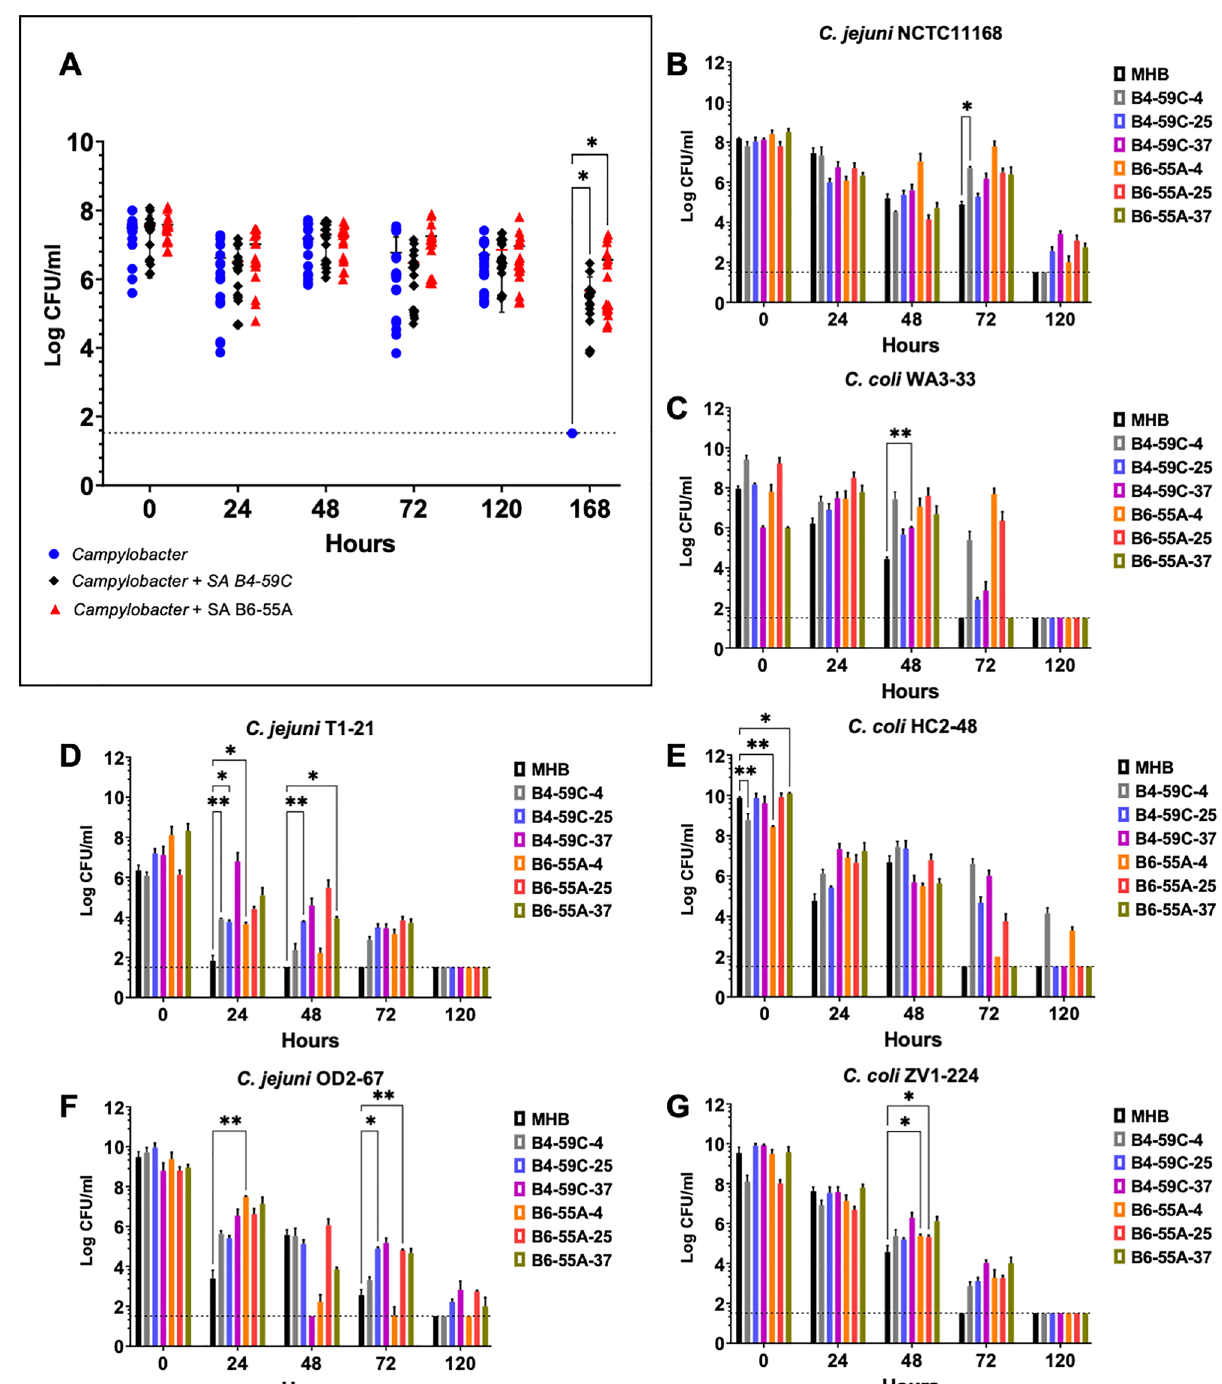
Figure 1. Survival of Campylobacter strains at low temperature (4 °C) in mono or mixed cultures containing S. aureus strains or cell-free extracts. ( A ) Survival of Campylobacter strains (all C. jejuni and C. coli strains) monocultures and mixed cultures containing S. aureus B4-59C or B6-55A. All individual viable count readings from Campylobacter monocultures or mixed cultures are represented in figure ( A ). Survival of ( B ) C. jejuni NCTC11168, ( C ) C. coli WA3-33, ( D ) C. jejuni T1-21, ( E ) C. coli HC2-48, ( F ) C. jejuni OD2-67 and ( G ) C. coli ZV1-224 in media containing cell-free extracts of S. aureus at 4 °C. The cell-free extracts were obtained from S. aureus B4-59C grown at 4, 25, and 37 °C (B4-59C-4, B4-59C-25, B4-59C-37) and S. aureus B6-55A grown at 4, 25, and 37 °C (B6-55A-4, B6-55A-25 and B6-55A-37). Campylobacter cells grown in non-amended MHB served as a control. Each bar in figures ( B – G ) represents the mean of colony counts with standard deviation (SD) error bar. Horizontal dotted lines in the figures represent the limit of detection for colony counts (LOD, ~ 33 CFU/ml) in these assays. All data points plotted on the LOD line in figure ( A ) and all the bars not exceeding LOD line in figures ( B – G ) represent the readings for the respective time points with no detectable CFU counts. Tukey multiple comparison tests (Two-way ANOVA with repeated measures) was conducted in GraphPad Prism 9: * p < 0.05, ** p < 0.01, *** p < 0.001, **** p <